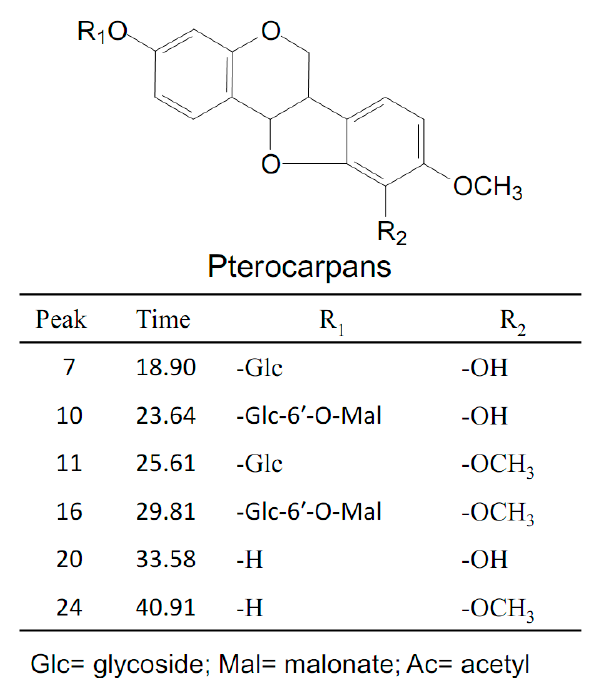
Figure 3. Chemical structures of the isoflavonoid compounds identified in Astragali Radix.